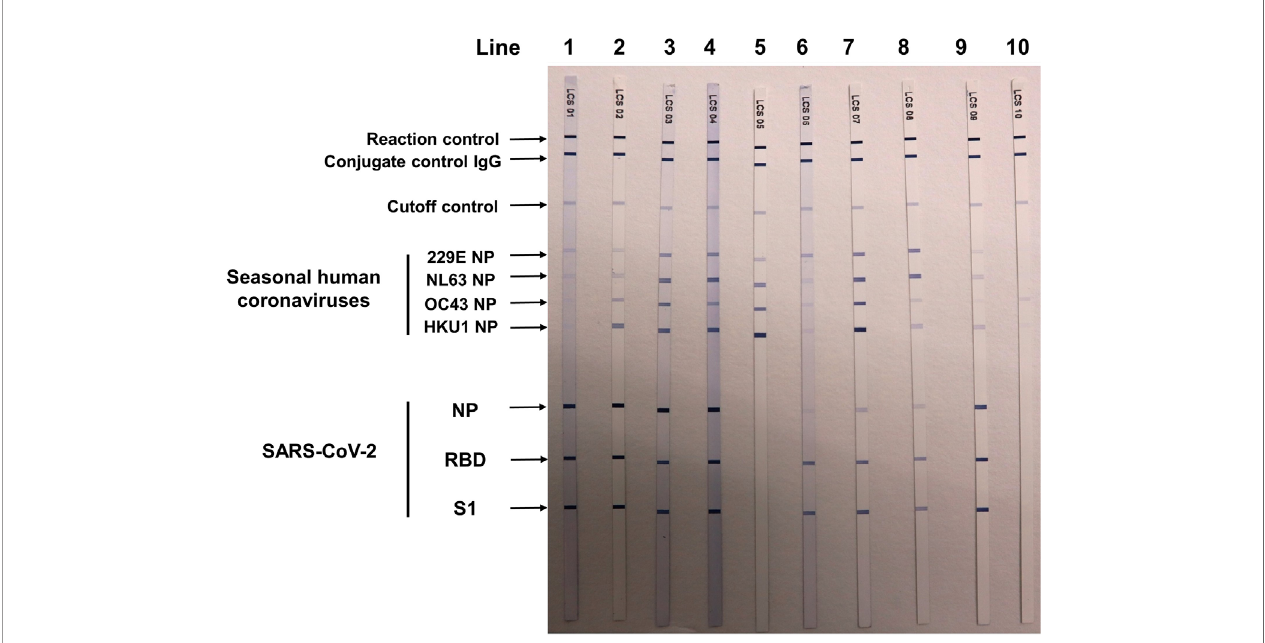
FIGURE 3 | Results of recom Line SARS-CoV-2 IgG [Avidität] line immunoassay (MIKROGEN Diagnostik GmbH, Neuried, Germany) for two qRT-PCR-con fi rmed COVID-19 patients and eight participants in the seroprevalence survey. Lines 1 and 2: two patients with qRT-PCR-con fi rmed COVID-19 patients treated at National Taiwan University Hospital (NTUH). Lines 3 – 5: participant nos. 1 and 2 and 6 in Table 2 . Lines 6 – 9: four healthcare workers (nos. 1, 5, 6, and 8 in Table 3 ) with SARS-CoV infection in 2003. Line 10: a patient visited NTUH with acute respiratory infection, and triplicate qRT-PCR testings for SARS-CoV-2 from respiratory samples were negative. NP, nucleocapsid protein; RBD, receptor-binding domain; S1, spike subunit